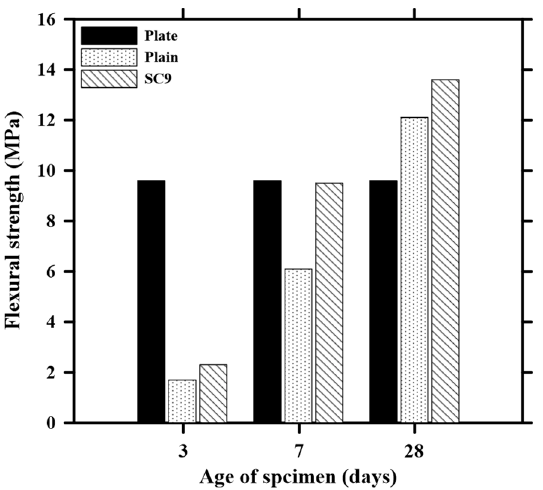
Figure 12. Flexural strength after application of repair composites.